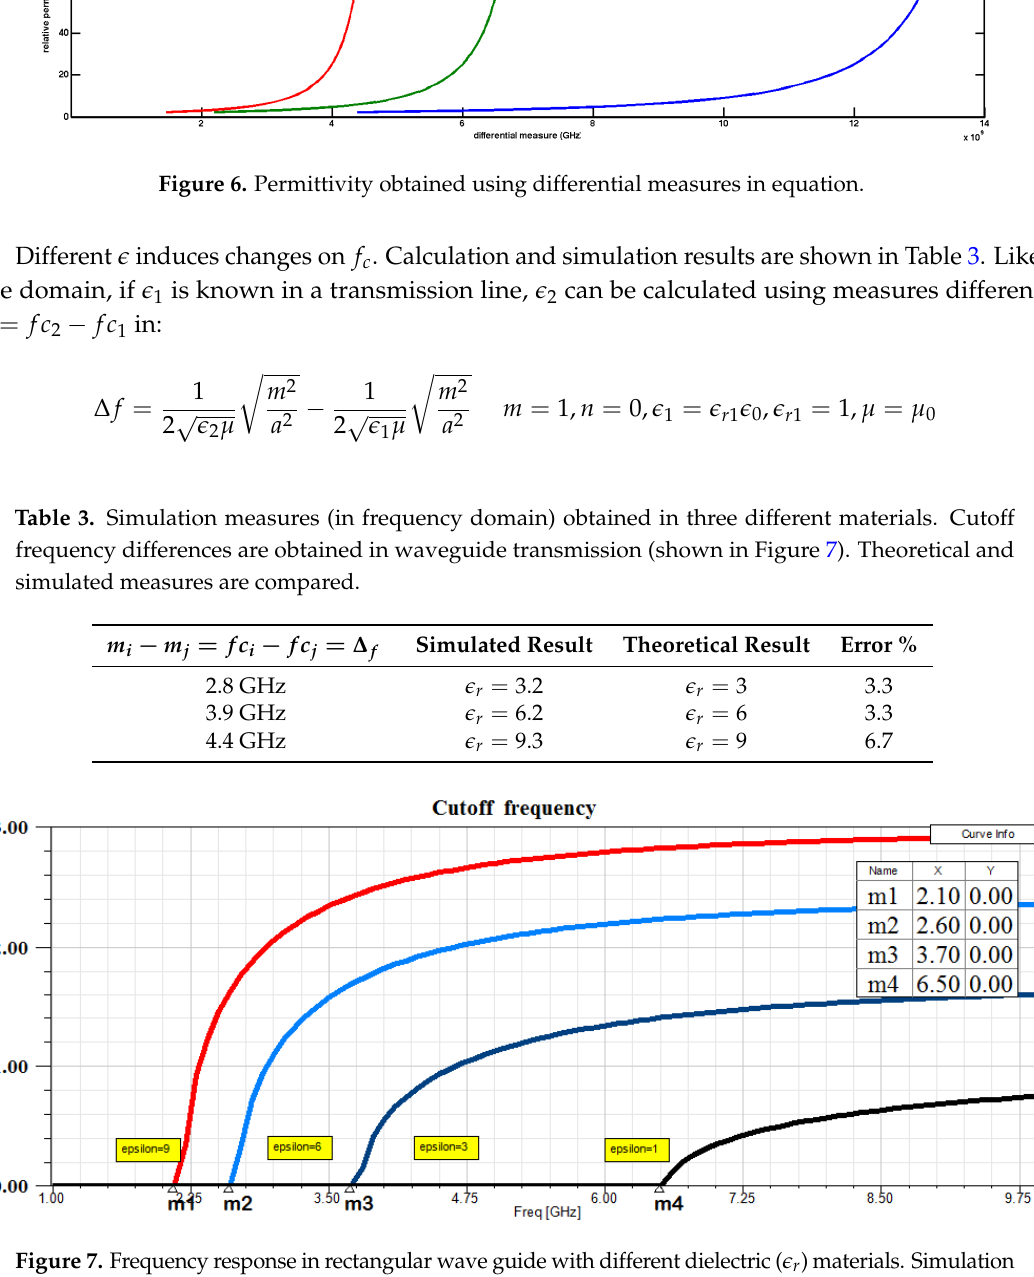
Figure 7. Frequency response in rectangular wave guide with different dielectric ( (cid:101) r ) materials. Simulation using HFSS software is performed. Differences in cutoff frequencies ( m i − m j = fc i − fc j = ∆ f ) are obtained to calculate unknown (cid:101) r